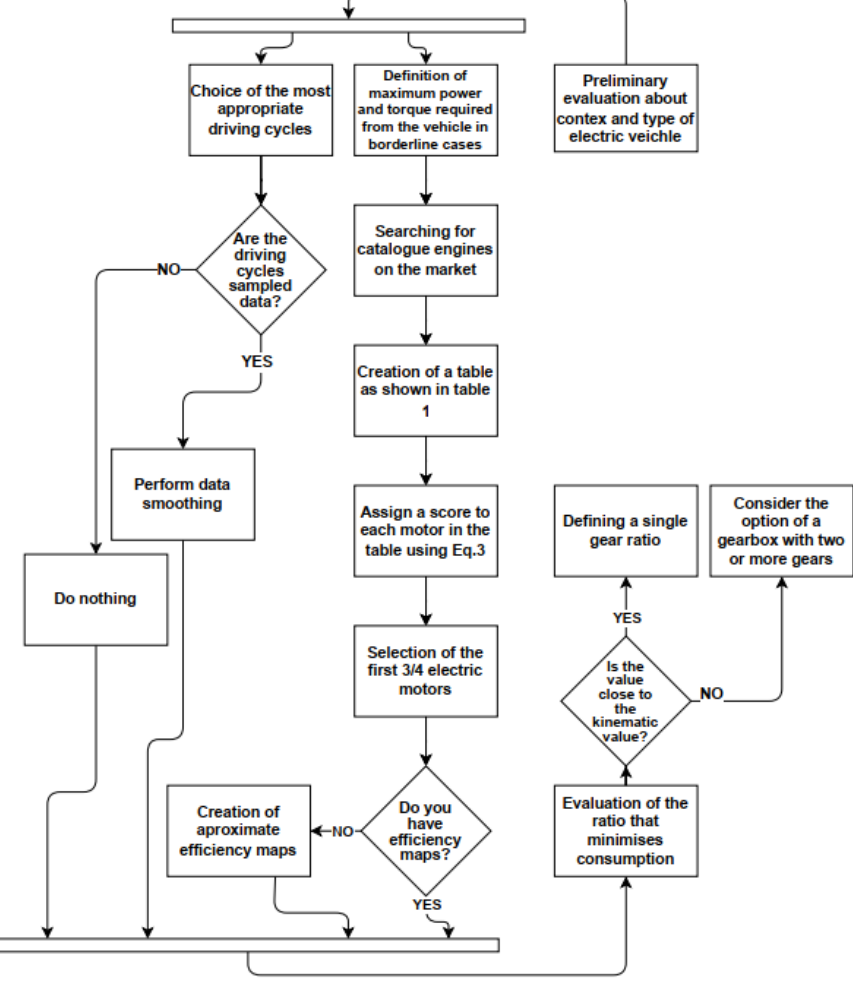
Figure 3. Flow chart of the electric motor selection